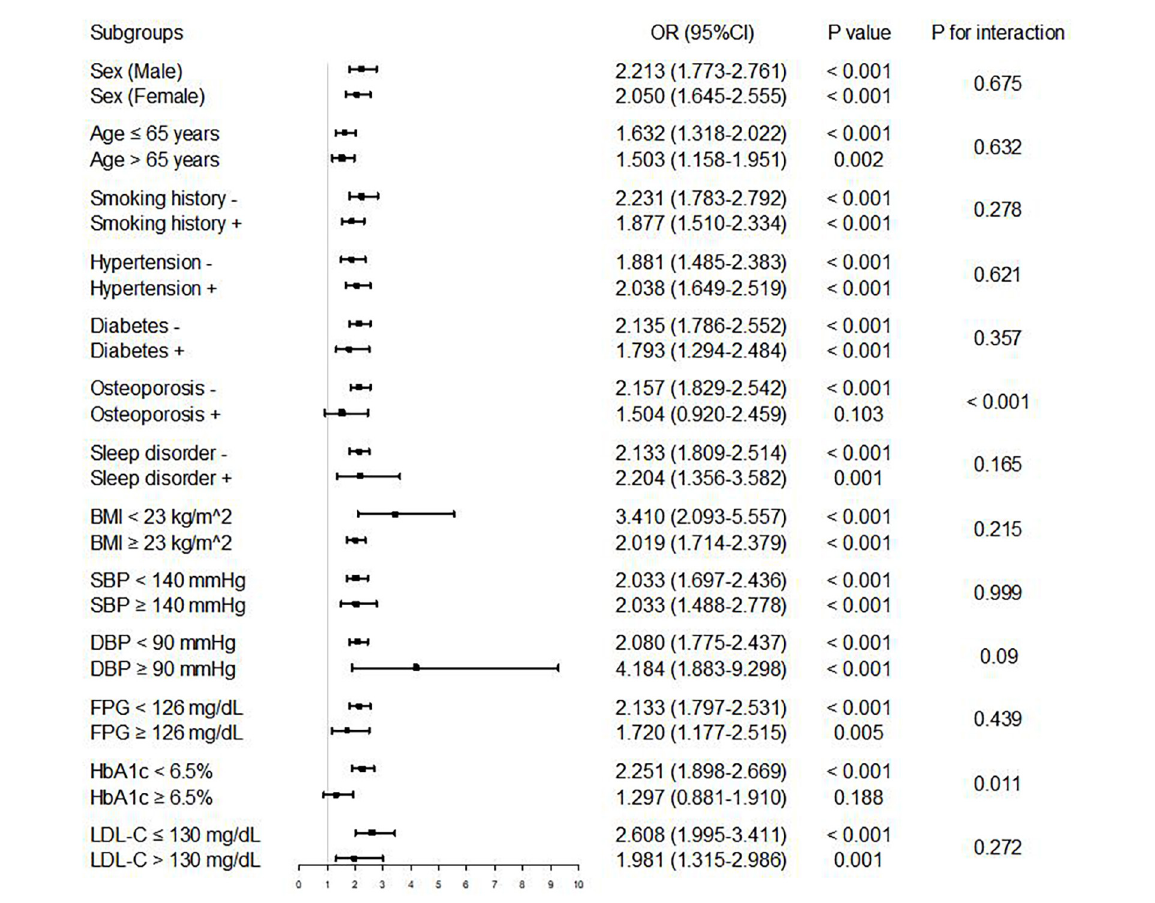
FIGURE4 Logistic regression analysis of associations between ABSI and AAC in different subgroups. The OR was examined regarding lower ABSI as reference (stratified by the optimal cutoff point of ABSI determined by ROC curve analysis). P value < 0.05 and P for interaction < 0.05 were regarded as statistically significant. ABSI, a body shape index; BMI, body mass index; SBP, systolic blood pressure; DBP, diastolic blood pressure; FPG, fasting plasma glucose; HbA1c, hemoglobin A1c; LDL-C, low-density lipoprotein cholesterol; OR, odds ratio; CI, confidence interval.